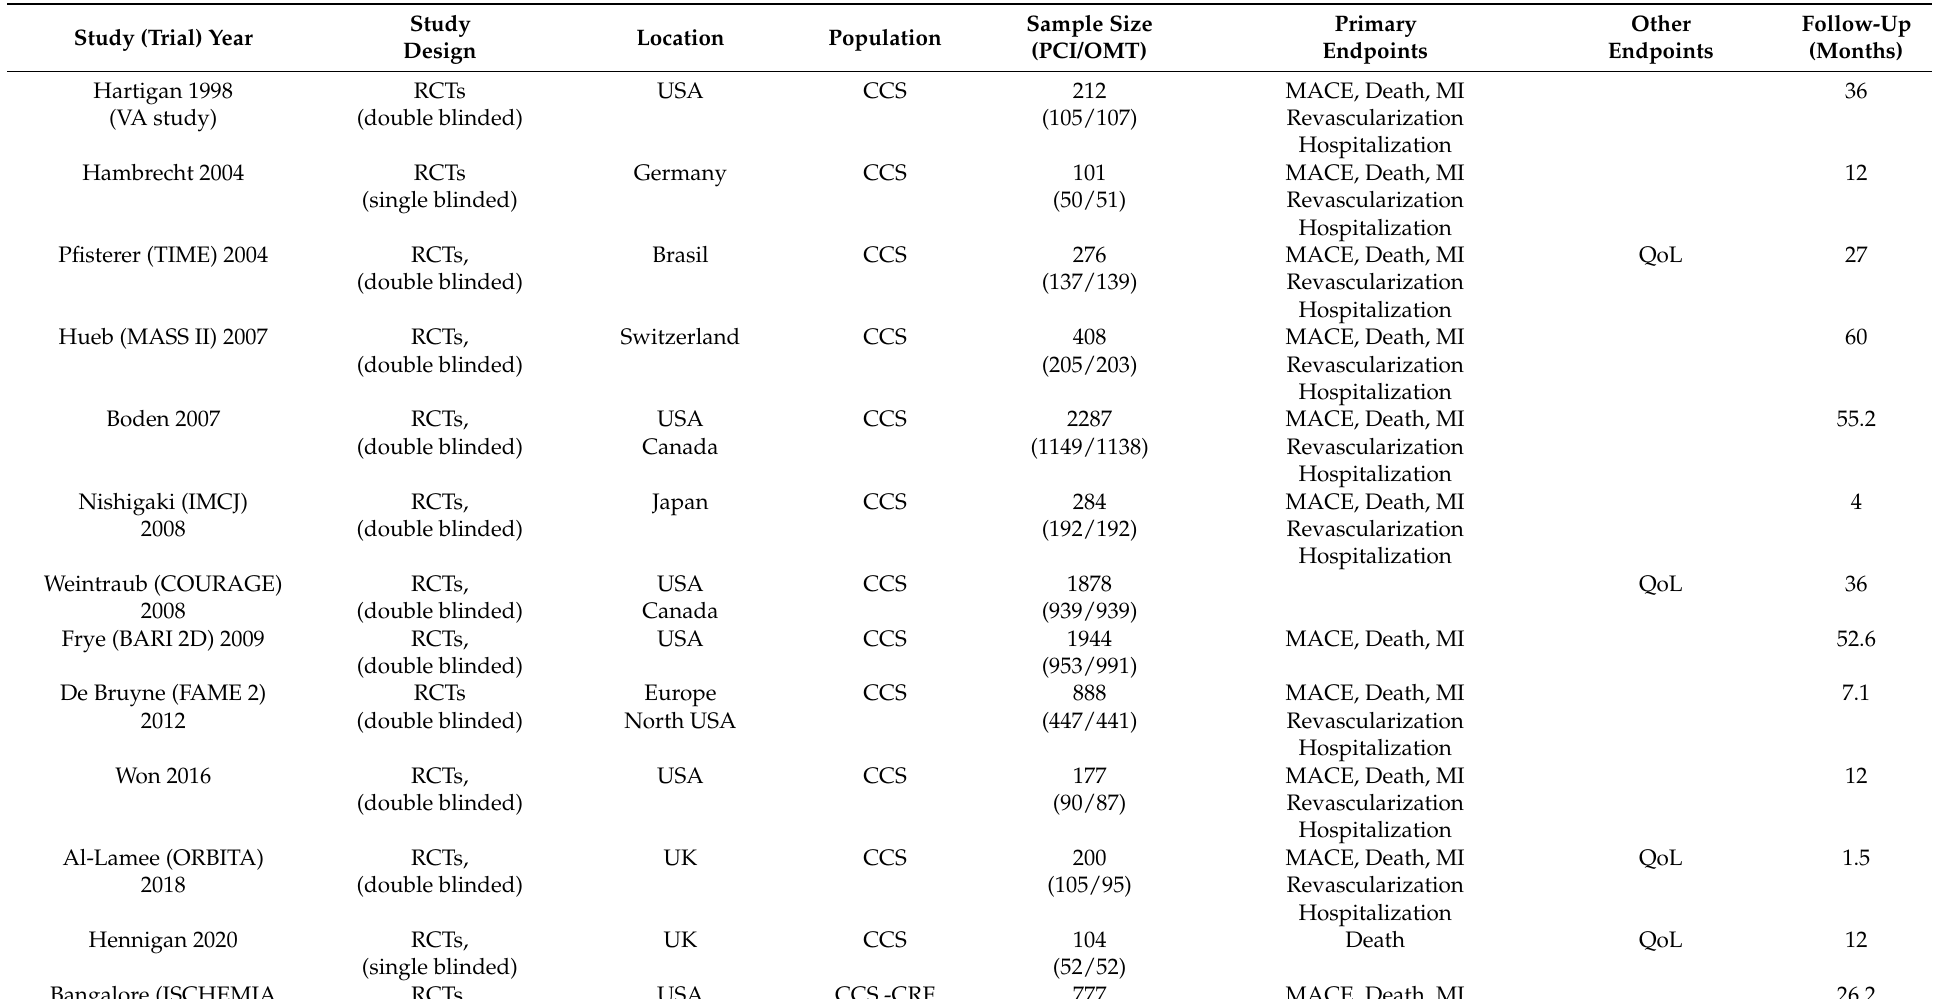
Table 1. Main characteristics of trials included in the